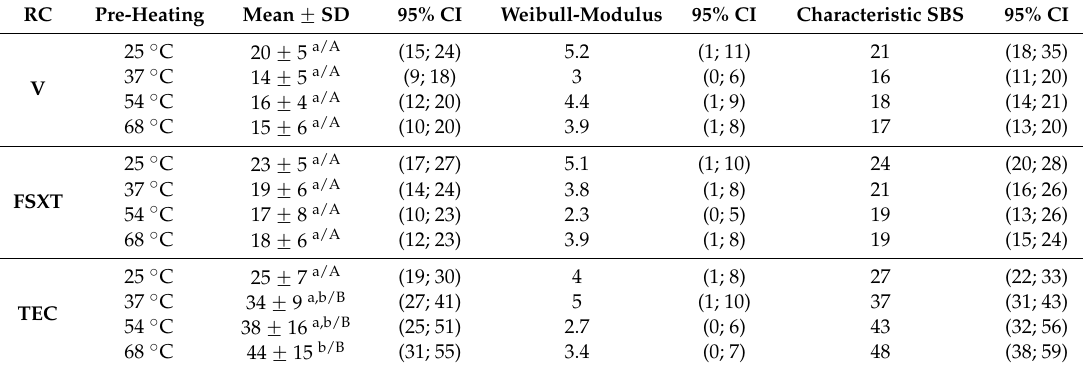
Table 4. Mean with standard deviation for SBS to ceramic (MPa) appendant Weibull modulus and characteristic SBS as well as 95% confidence interval (CI) for each tested RC by each pre-heating